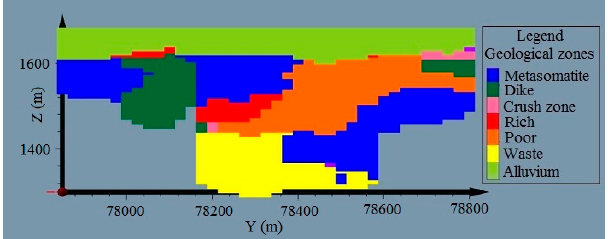
Figure 9. Vertical section of the estimated ore body showing indicator co-kriging (ICK) results.